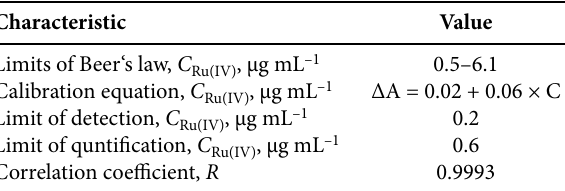
Table 1. The metrological characteristics of spectrophotometric de- termination of the Ru(IV) with HITO ( C (HITO) = 8.0 × 10 –4 mol L –1 ; C (CH 3 COOH + CH 3 COONa) = 0.32 mol L –1 ; C (NaCl) = 0.1 mol L –1 ; pH = 5.0; λ = 350 nm; l = 1.0 cm; n = 5; P = 0.95)